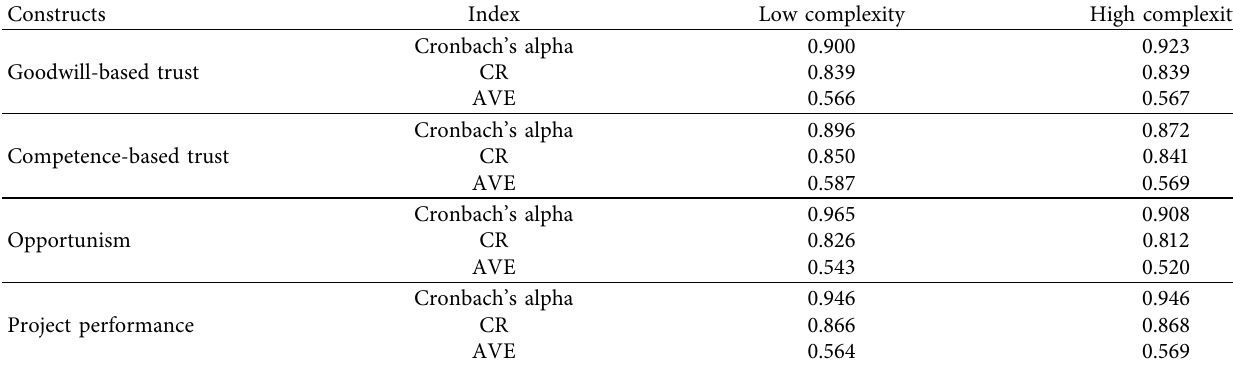
Table 4: Measurement reliability and convergent validity assessment.